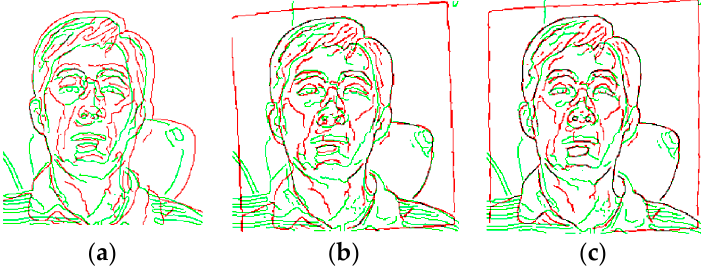
Figure 5. Edge map pairs view of registered visible (green) and IR (red) images with the ( a ) coarse, ( b ) coarse-Demons, and ( c ) coarse-spline methods.